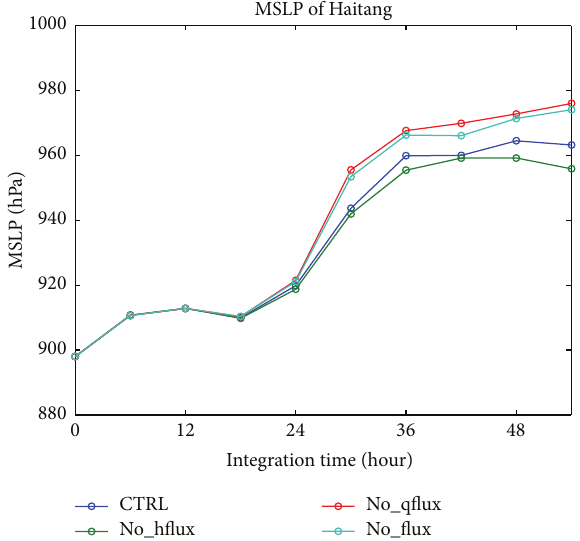
Figure 5: Time series of the modeled minimum central sea level pressure (hPa) of each experiment from 0000 UTC 17 July to 0600 UTC 19 July